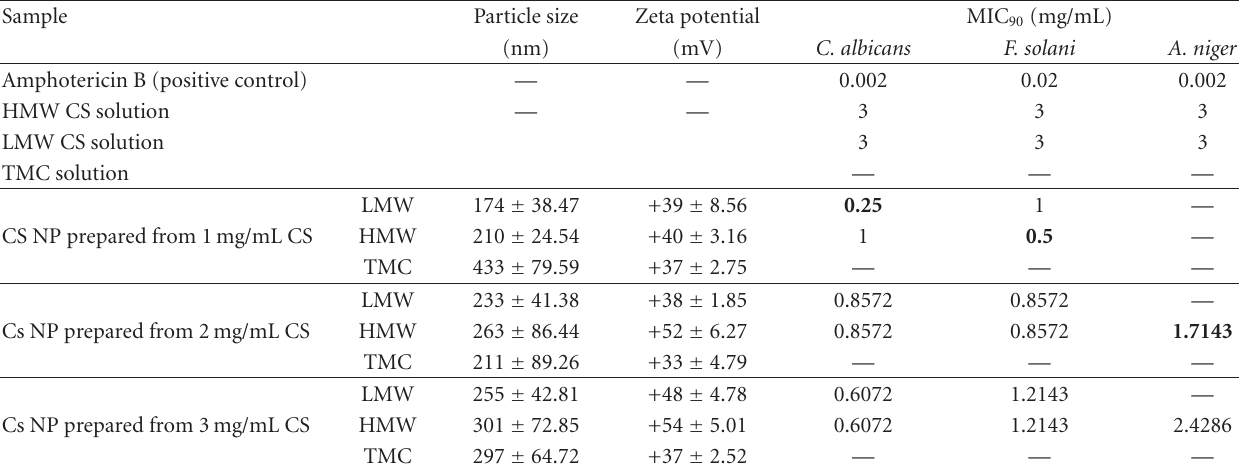
Table 3: Antifungal activity of chitosan solution and nanoparticles against selected fungi species, n = 3. CS: chitosan; NP: nanoparticles.